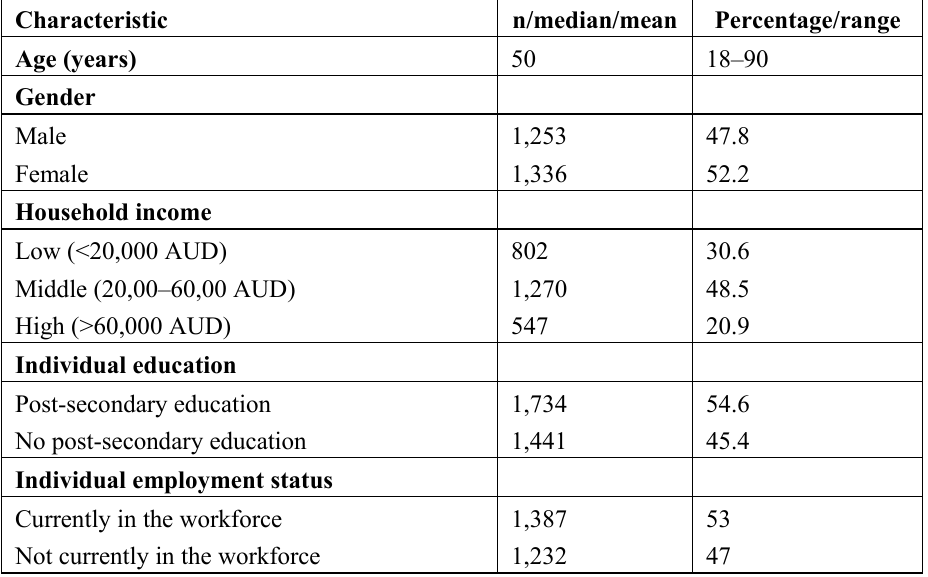
Table 1. Baseline characteristics of participants included in analyses (n =